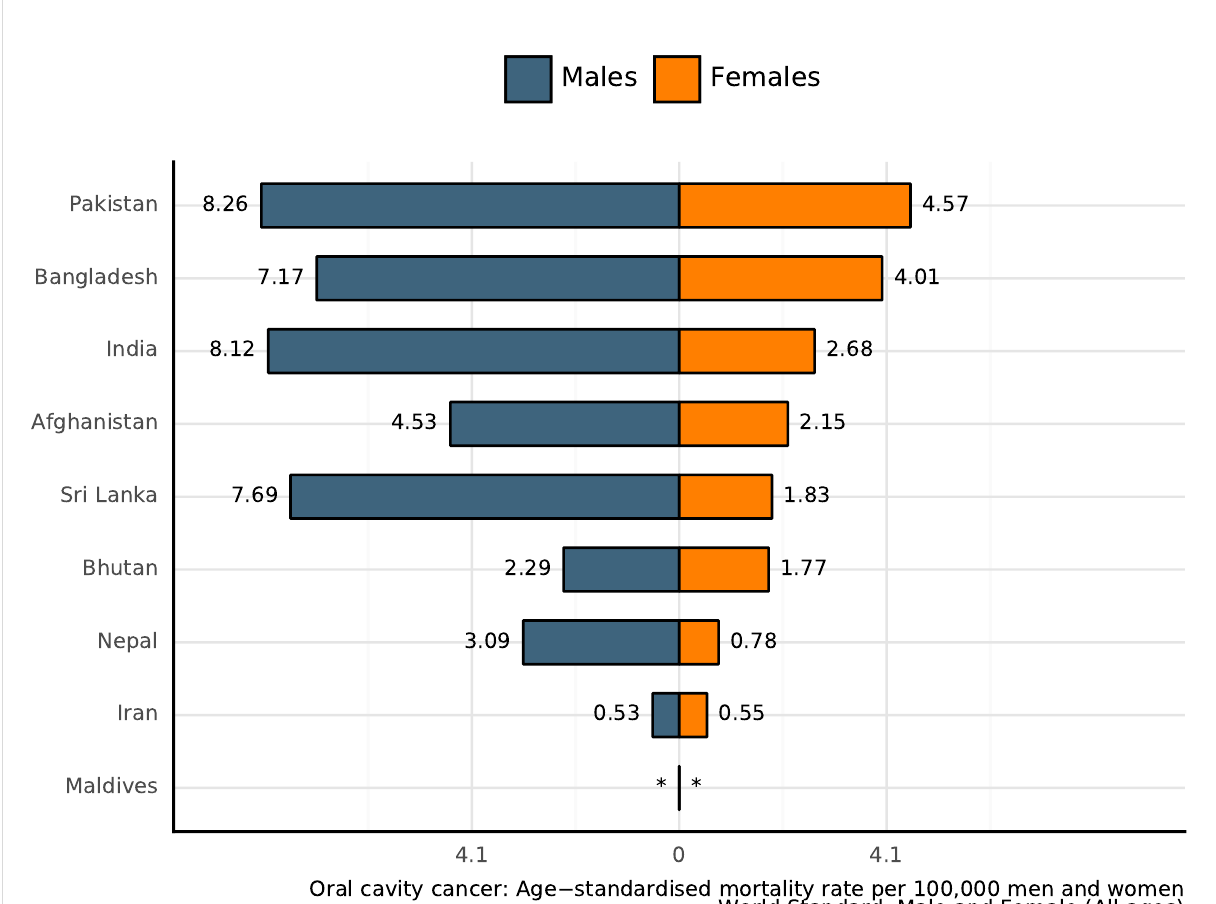
4.1 0 4.1 Oral cavity cancer: Age standardised mortality rate per 100,000 men and women World Standard. Male and Female